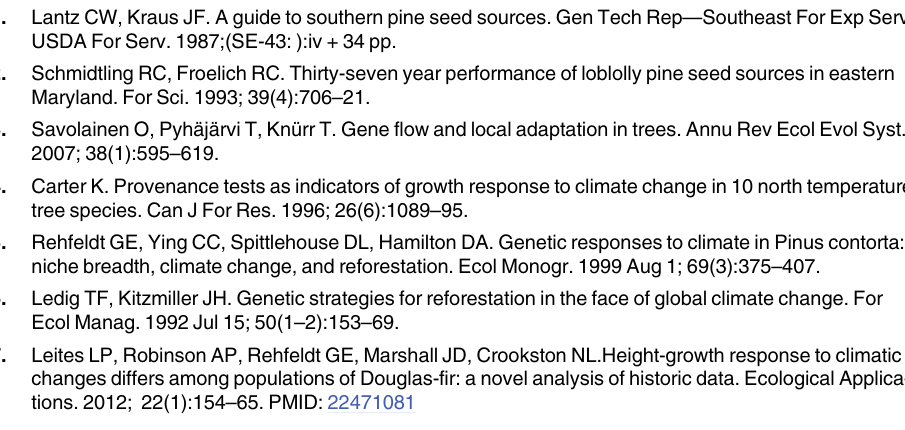
source locational or climatological characteristics. The red dot indicates the mean tree-ring width value for all trees from a single seed source. The black lines are trees from the Volunteer population. S2 Fig. Seed source chronologies. All seed source chronologies are arranged from north to south going down each column from left to right. S1 Table. Annual bootstrap growth comparison between seed source groups. X indicates that the first seed source group listed has significantly higher average growth than the second group listed ( p < 0.05). The bottom row shows the overall percentage of significantly different years from 1980 –